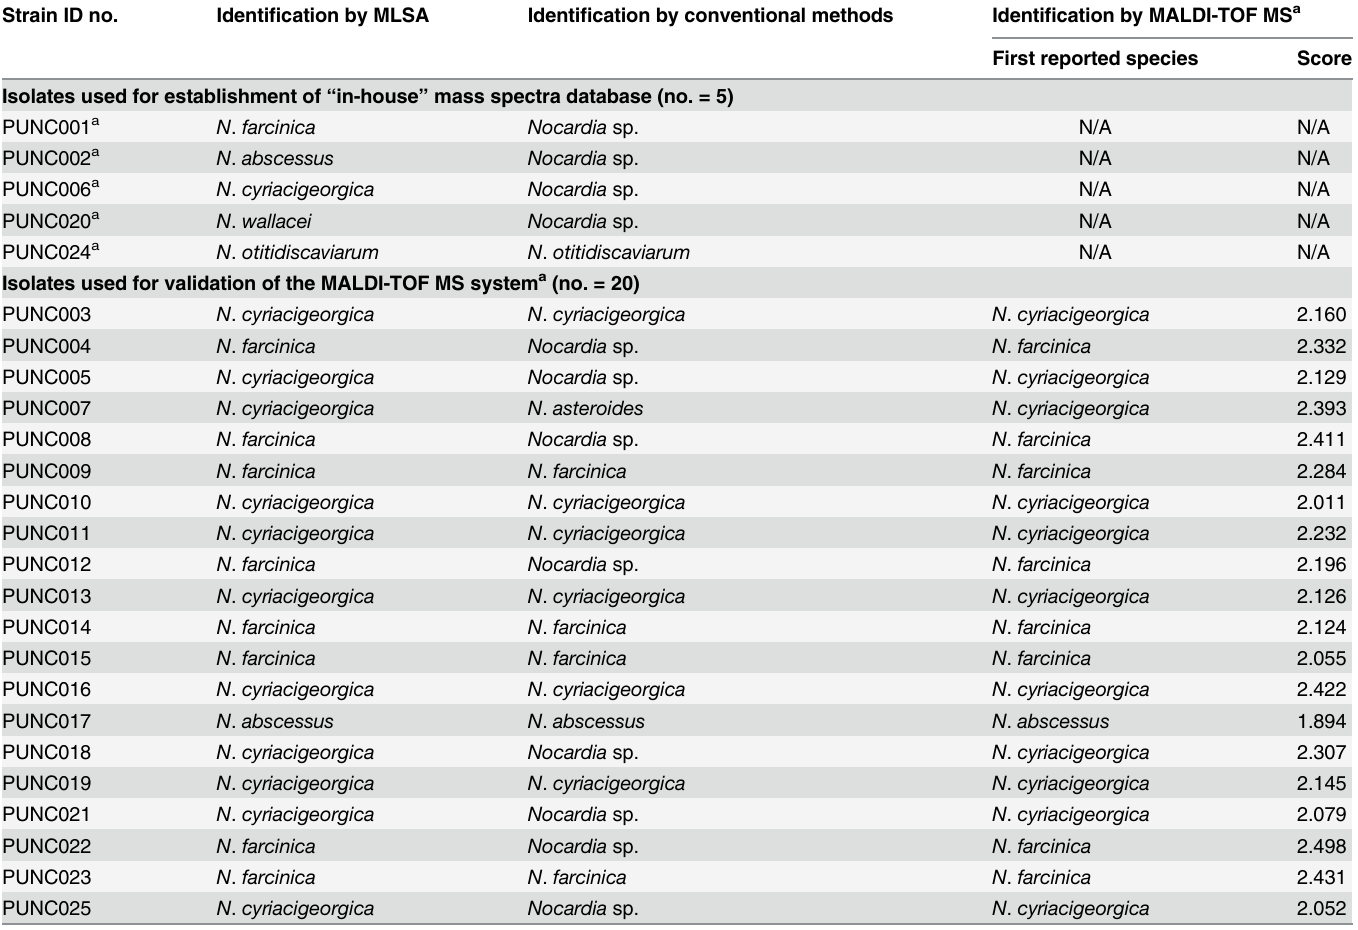
Table 2. Identification results of 25 Nocardia clinical isolates by DNA sequencing and MALDI-TOF MS after interrogation against the Biotyper data- base (version 3.1) and the “ in-house ” database. Strain ID no.